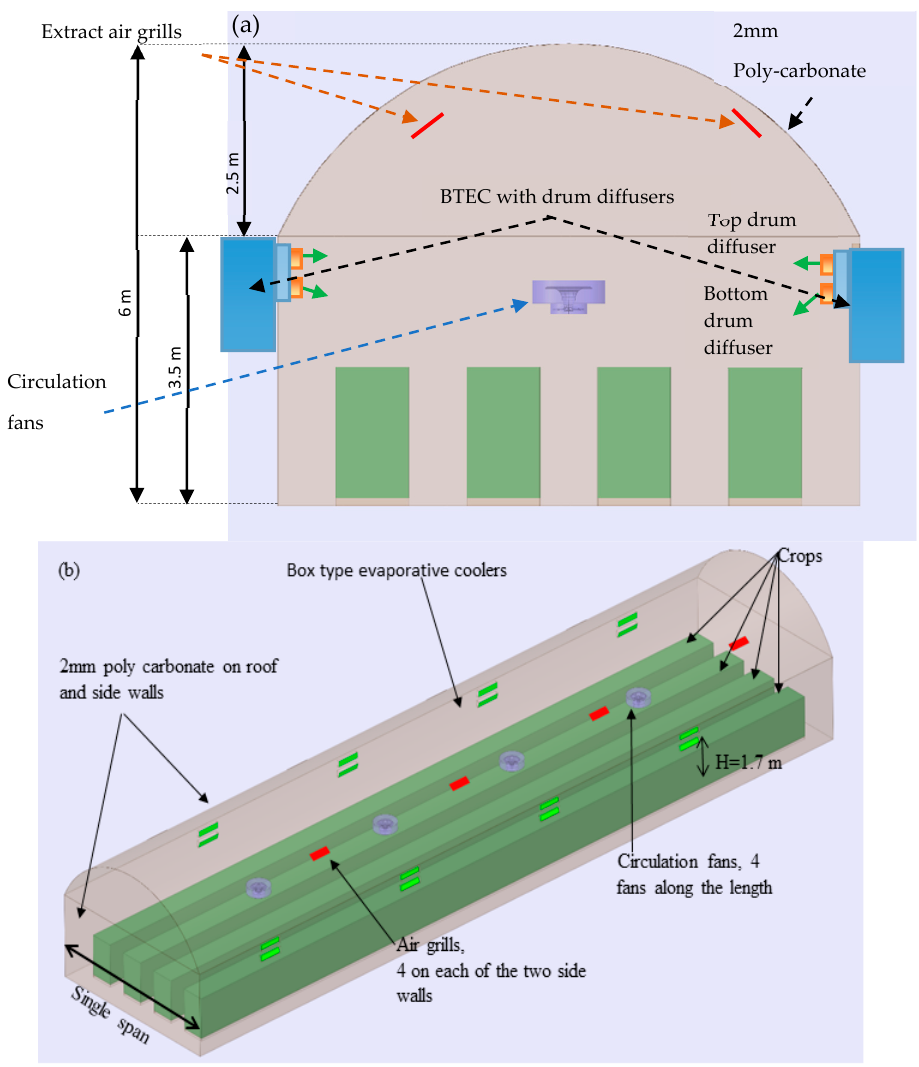
Figure 2. ( a ) 2D front view showing single span greenhouse. Location of the evaporative units, each with two drum diffusers; the extract air grills and the circulation fans are also shown. ( b ) 3D isometric view of the greenhouse. The location of the evaporative units on the side walls along the length of the greenhouse is seen. The heat load locations of the greenhouse used for CFD simulation are also shown.